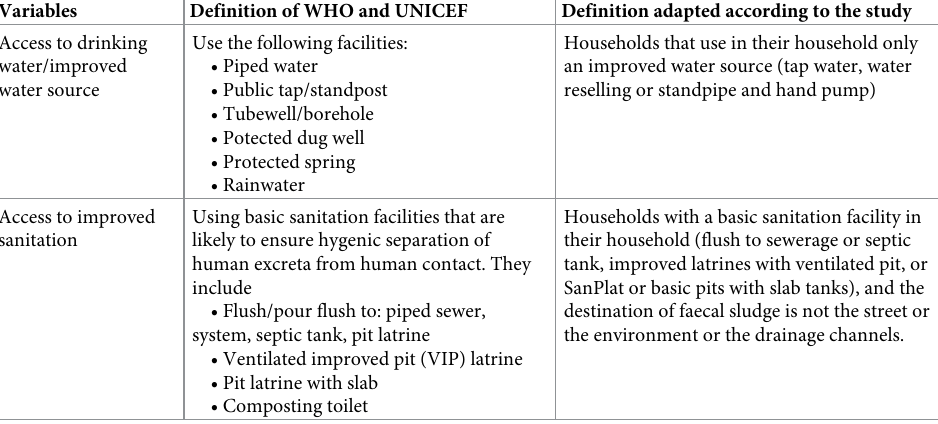
Table 1. Definition of access to drinking-water and improved sanitation according to WHO and